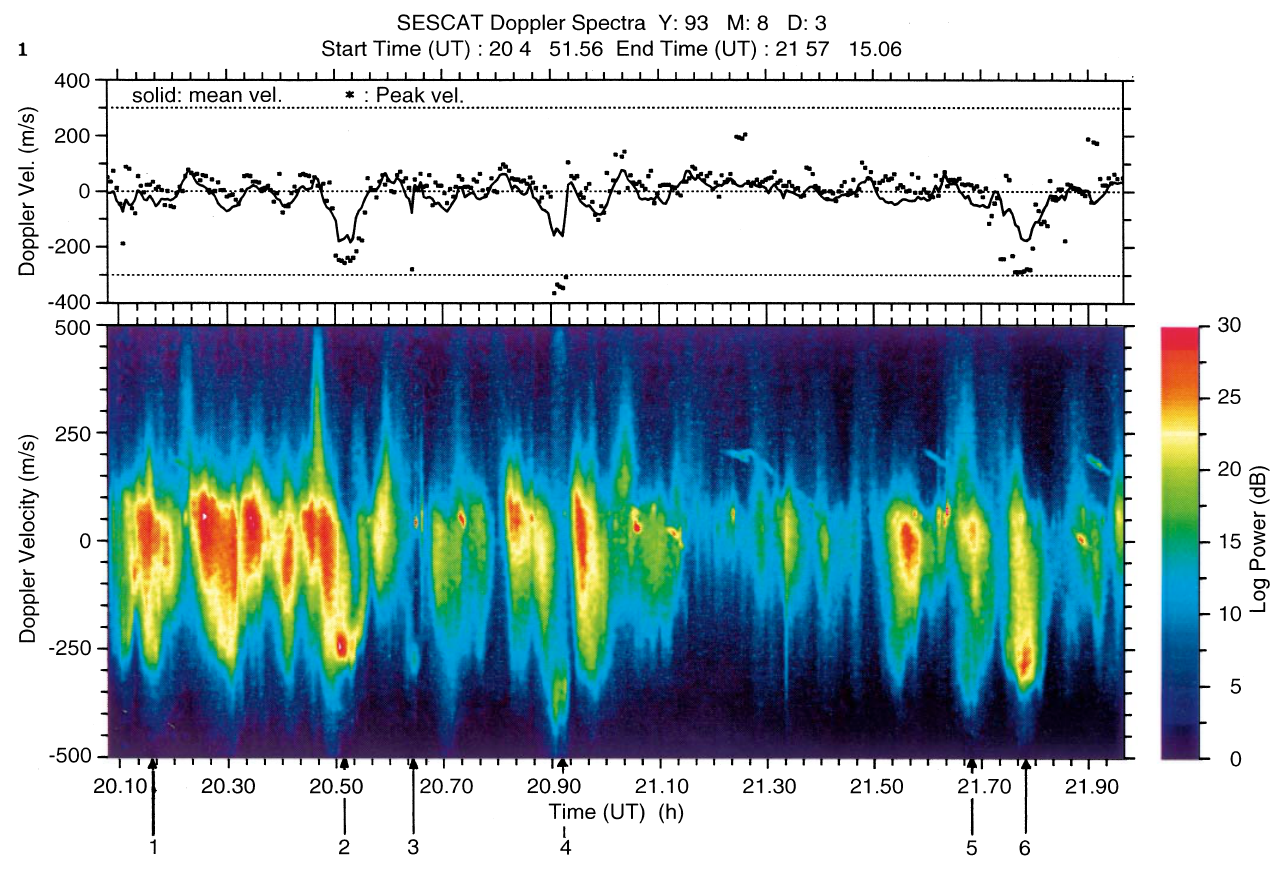
echoes, characterized by narrow spectral peaks at velocities higher than 250 m/s (see Fig. 3). Note that the times are in decimal hours, not hours and minutes, but the tick marks are every